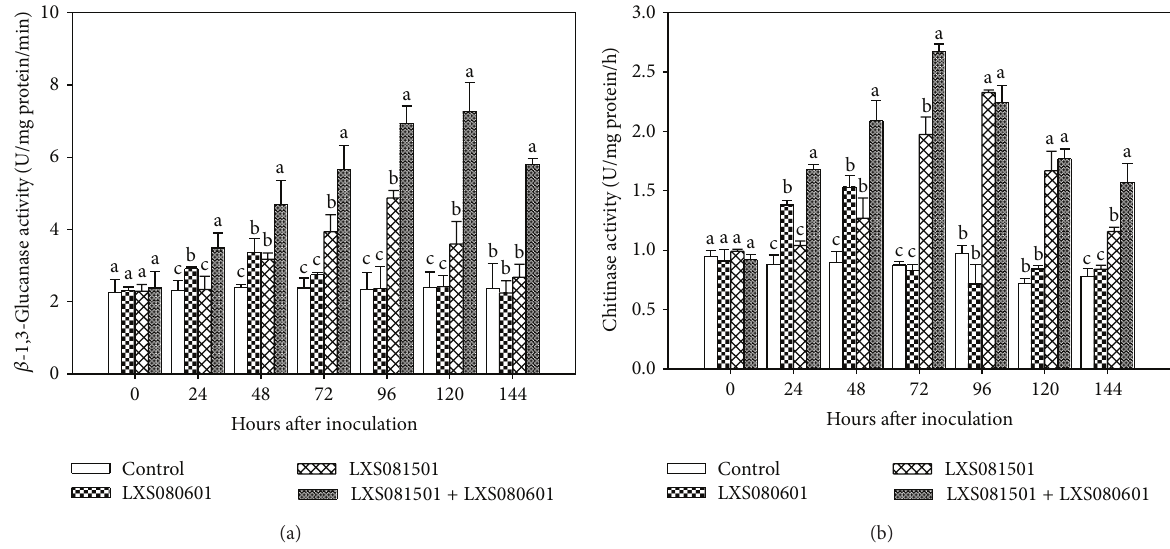
Figure4:Timecourseof 𝛽 -1,3-glucanase(a)andchitinase(b)activitiesinextractsfromapplecalliinoculatedwithPDA(control),LXS080601, LXS081501, and LXS081501+LXS080601. Data represent the mean of “Fuji” and “Gala” cultivars in two independent experiments. Error bars represent standard error of the mean. Different letters on the bar show statistical significance ( 𝑃 < 0.05 ) in 𝛽 -1,3-glucanase and chitinase activities at the same